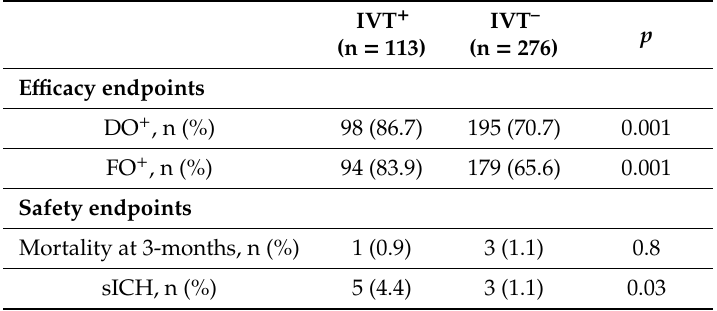
Table 2. E ffi cacy and safety endpoints in patients treated and not treated with